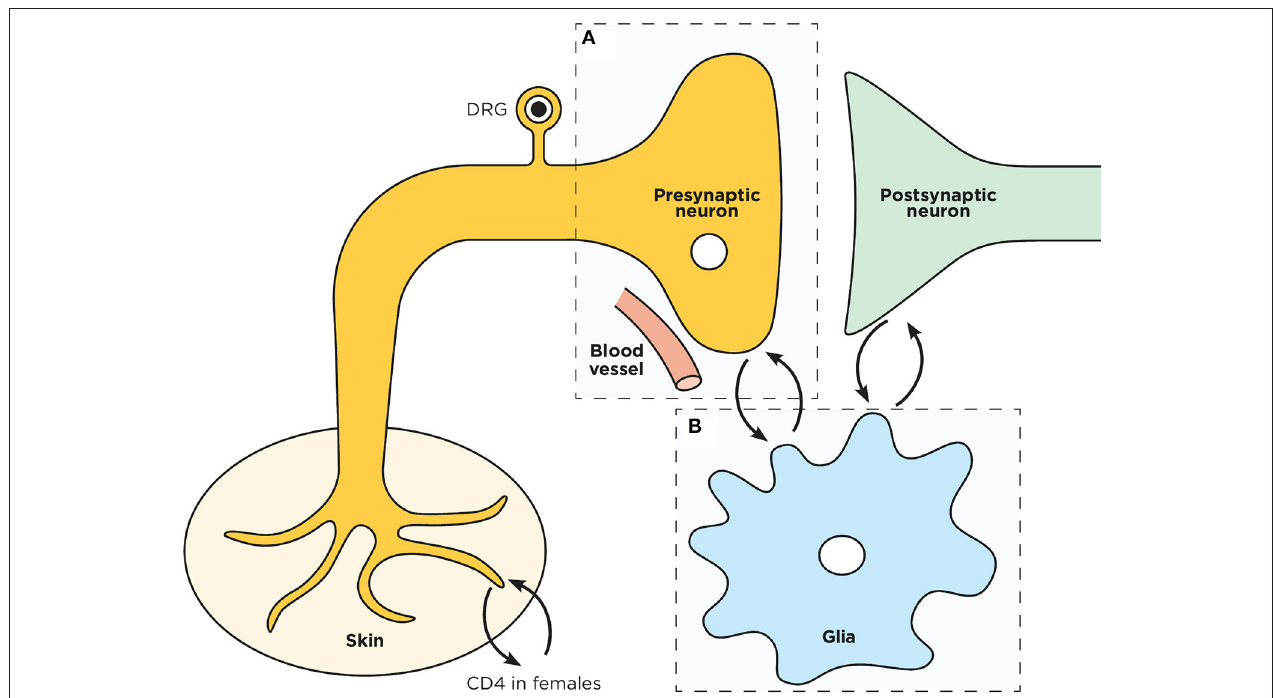
FIGURE 1 | Schematic representation of a spinal dorsal horn tripartite synapse. Overview of the pre (A) and post- synaptic neurons interplay with microglia (B) in the spinal cord dorsal horn.